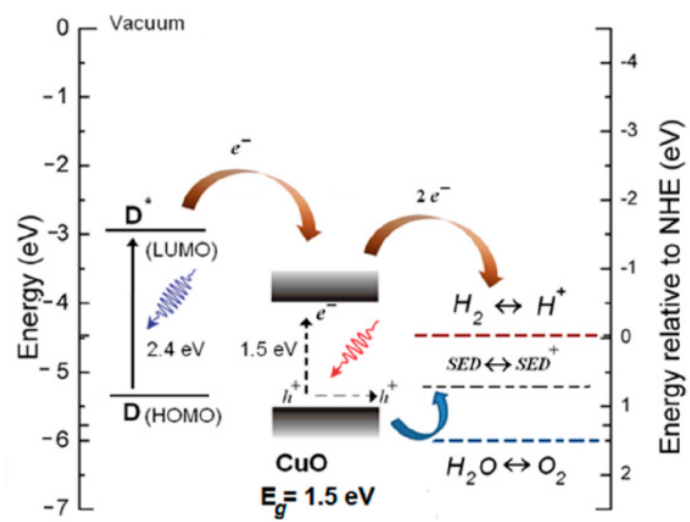
Figure 17. Proposed schemes of light absorption and electron transfer in dye-sensitized CuO. ( D *) represents the photoexcited mercurochrome that injects electrons into the CB of CuO thus trans- forming into the dye cation D + . Adopted from [214] with permission of the American Chemical Society. LUMO: Lowest Unoccupied Molecular Orbital of mercurochrome; HOMO; Highest Occupied Molecular Orbital of mercurochrome; SED: possible oxidizable chemical specie in solution.